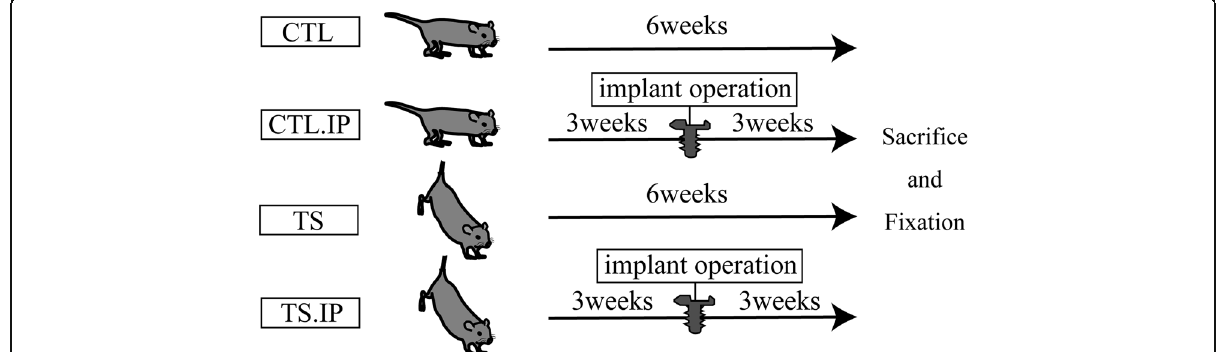
Fig. 1 Experimental protocol. We compared tail suspension mice to normal-reared mice. Implant surgery was performed after 3 weeks of tail